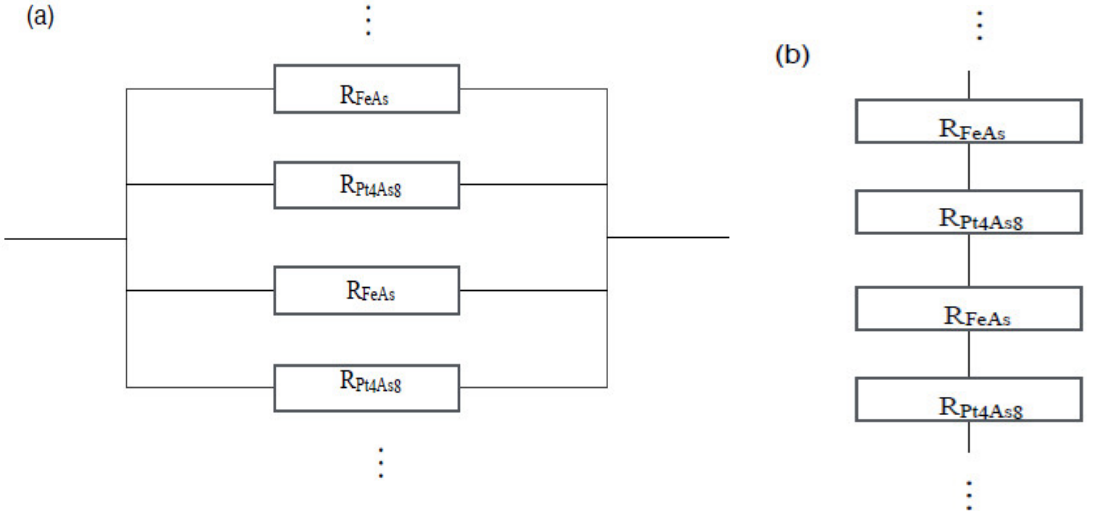
Figure 4. ( a ) A schematic plot of resistors made of FeAs layers and Pt 4 As 8 layers connected in parallel; ( b ) a schematic plot of resistors made of FeAs layers and Pt 4 As 8 layers connected in series.